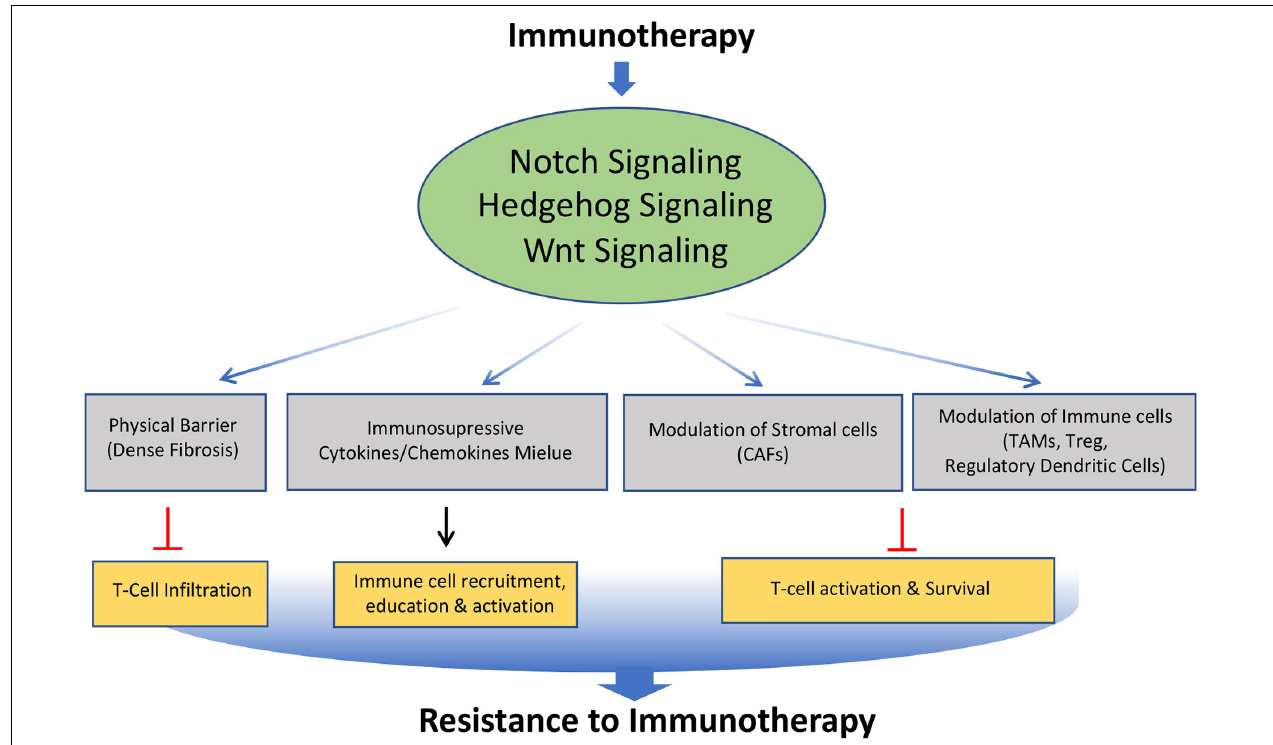
FIGURE 5 | Role of Notch, Hedgehog, and Wnt signaling pathways involved in the acquisition of resistance to immunotherapy. Altered modulation of Notch, Hedgehog, and Wnt signaling by immunotherapy leads to modification of tumor microenvironment such as formation of dense fibrosis, secretion of immunosuppressive cytokines and chemokines, Cancer Associated Fibroblast (CAFs), Tumor Associated Macrophage (TAMs), regulatory dendritic cells. This affects the trafficking, survival and activation of T cells, leading to acquisition of immunotherapy